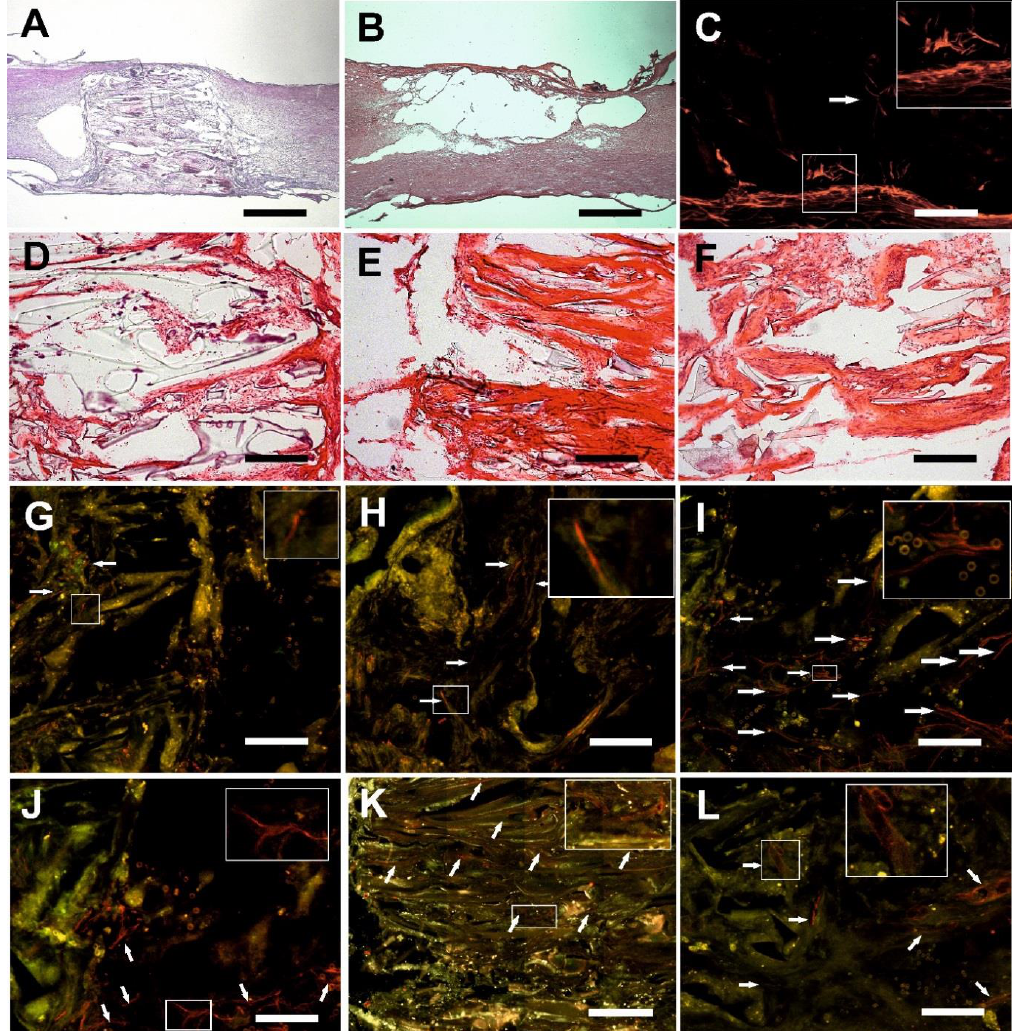
Figure 4. The mosaic presents various aspect of tissue ingrowth within the pores of the three methacrylate hydrogels. ( A ) HEMA-Fn sufficiently bridged the hemisection cavity. In some cases there were minor cavities on the border. The HEMA-Fn scaffold serves as a representative sample for all three methacrylate hydrogels (HE staining, scale bar = 1 mm). ( B ) The lesion resulted in a large pseudocystic cavity in the control group (HE staining, scale bar = 1 mm). ( C ) Subtle astrogliosis was present within the spinal cord tissue neighboring the HPMA scaffold and a few islets of astrocytes also infiltrated its peripheral part (white arrow, GFAP-Cy3 staining, scale bar = 100 µ m). ( D ) Sparse connective tissue elements were found in the plain HEMA scaffold; there was a more dense infiltration within the pores of the HEMA-Fn ( E ) and the HPMA hydrogel ( F ) HE staining, scale bar = 100 µ m. ( G ) No axonal sprouts were present in the HEMA scaffold, however, some axons (white arrows) reached the border zone of the spinal cord (NF160-g594 staining, scale bar = 25 µ m). ( H ) A small number of sprouts (white arrows) were present within the HEMA-Fn scaffold (NF160-g594 staining, scale bar = 25 µ m); significantly higher number of sprouts was present (white arrows) within the central parts ( I ) as well as the periphery ( J ) of the HPMA hydrogels (NF160-g594 staining, scale bar = 25 µ m). ( K ) Blood vessels (white arrows) grew abundantly within the pores of all three hydrogels especially the HEMA-Fn scaffold, as seen in this image (RECA-g488 staining, scale bar = 50 µ m). ( L ) A detailed view of the blood vessels within the HEMA-Fn scaffold (RECA-g488 staining, scale bar = 25 µ m). Insert boxes depict the typical elements described in each image of the mosaic (enlarged twice to the original